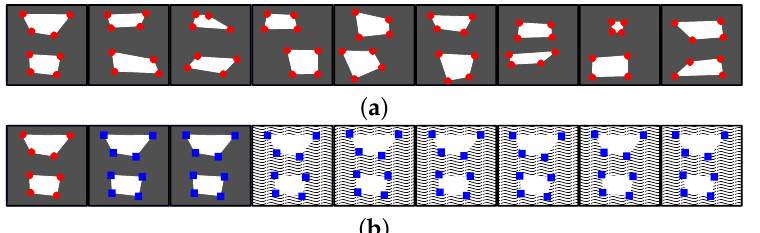
Figure 9. The different design method representations. Red dots represent design points, blue squares represent repeated points, the grey background shows FE simulated, and the wavy background shows non-FE simulated. ( a ) A complete domain where every chamber node is a design point and the entire actuator is simulated. This is a direct optimisation. ( b ) The hierarchical method is used where repetition is applied and only 3 elements are